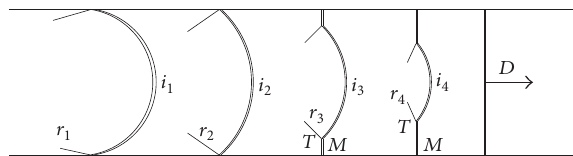
Figure 2: Variation trend of shock wavefront in the propagation process along the tube.